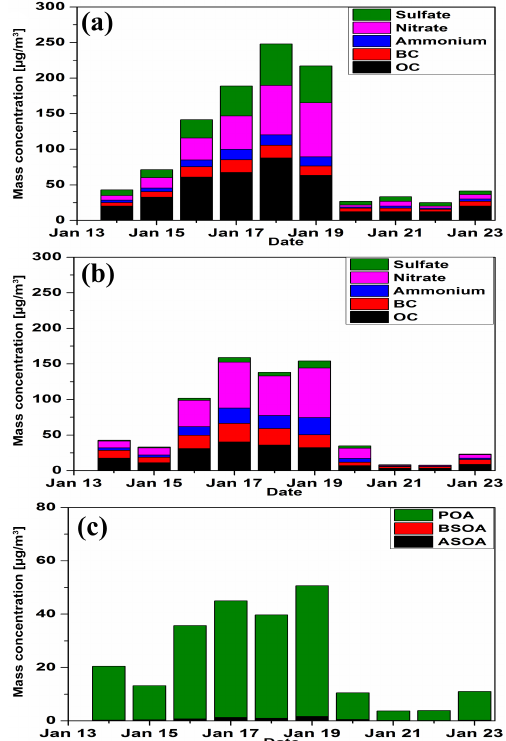
Figure 11. Observed (a) and simulated (b) chemical species of PM 2 . 5 and simulated SOA (c) in the Beijing